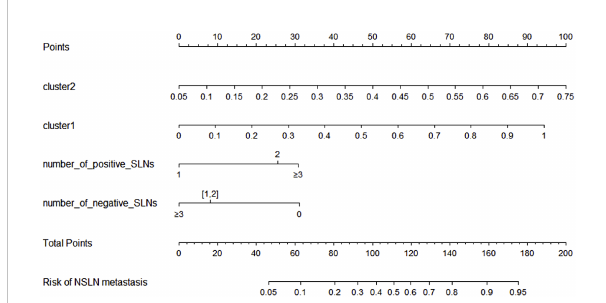
FIGURE 6 NSLN metastasis predictive nomogram integrated the four predictors selected by LDA-RFE. The fi rst row (Points) is the point assignment for each factor. Rows 2-5 represent the predictors included in the model. For an individual patient, each factor is assigned a point value based on the value range or characteristic. The assigned points for all four factors are summed, and the total is found in row 6 (Total Points). Once the total is located, the predicted risk of NSLN metastasis is con fi rmed in row